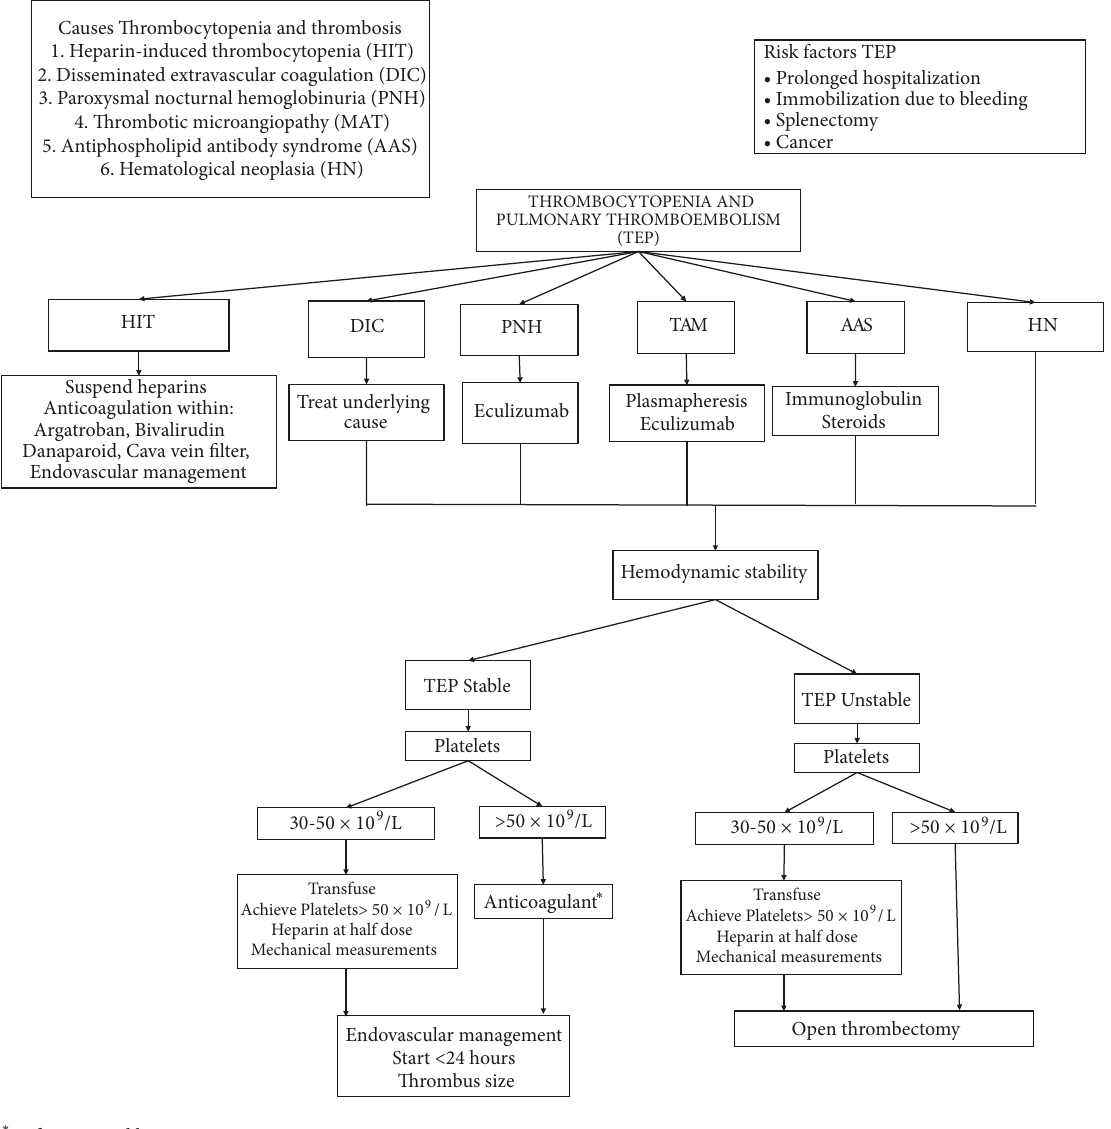
Figure 4: Algorithm for the management of pulmonary thromboembolism in a patient with associated thrombocytopenia.